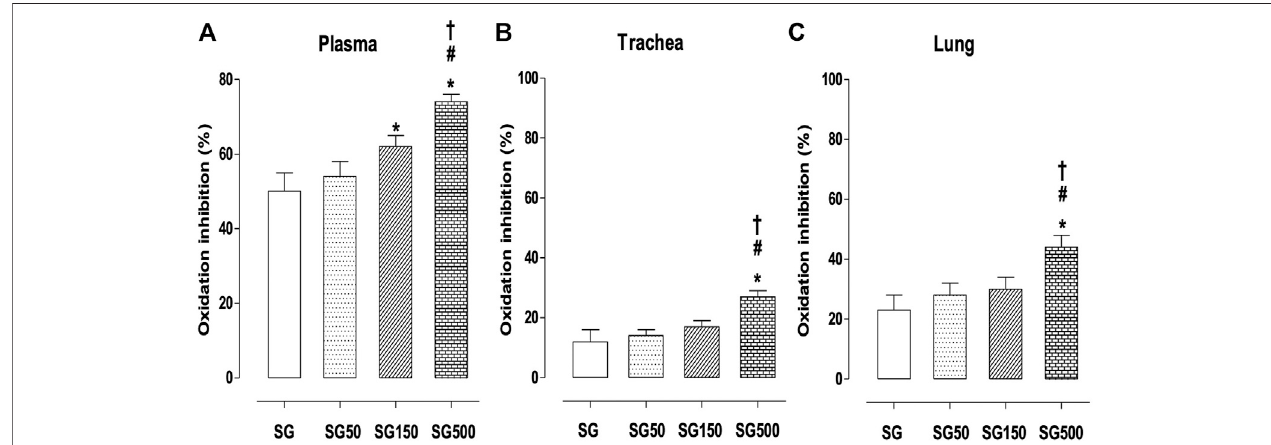
FIGURE4| Concentrationofnitriteinbloodplasma (A) ,trachea (B) andlung (C) fromSG(fx4),SG50(fx5),SG150(fx6),andSG500groups(fx7).Thecolumnsand vertical bars represent the mean and S.D., respectively (n = 10). One-way ANOVA followed by Bonferroni ’ s post-test. * p < 0.05 (SG vs . SG150 and SG500), # p < 0.05 (SG50 vs. SG500) and † p < 0.05 (SG150 vs. SG500). Healthy saline group = SG. Healthy group supplemented with S. platensis at 50, 150 and 500 mg/kg = SG50, SG150, and SG500, respectively.